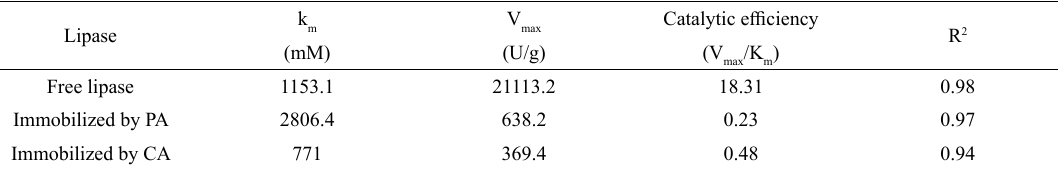
and V ) of free and m max